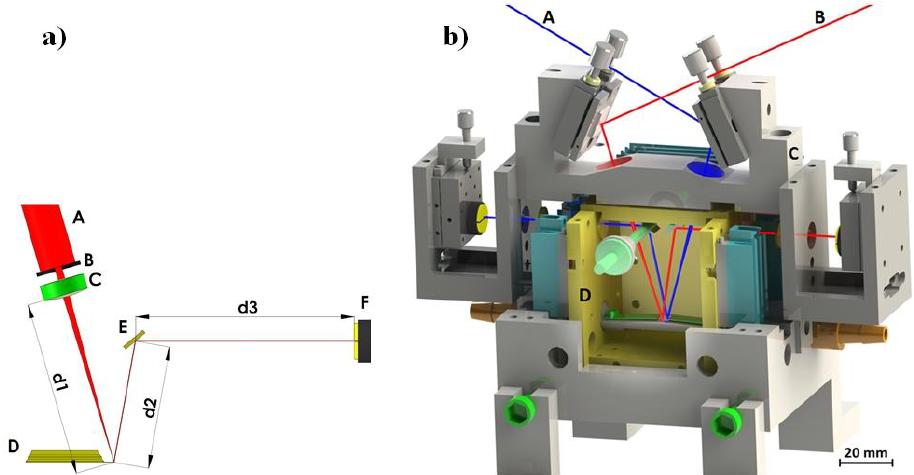
Figure 4. Optical detection principle and implementation. ( a ) A collimated diode laser light (λ = 635 nm, 5 mW) (A) passes through small aperture (B) and is focused at the backside of a cantilever (D) using f = 50 mm spherical lens (C). The reflected beam is directed onto a position sensitive photodiode (F) using a rotatable mirror (E). Distances d1, d2, and d3 are 48.3 mm, 34 mm, and 60.3 mm, respectively. ( b ) The optical detection system used for a precise detection of a functionalized (blue beam—A) and a reference (red beam—B) cantilever bending. The outer (gray—C) parts of the system are made of stainless-steel and designed to be as rigid as possible. The inner (yellow—D) temperature-controlled chamber is made of gold-plated copper, and thermally stabilized by several Peltier elements with an accuracy of a few